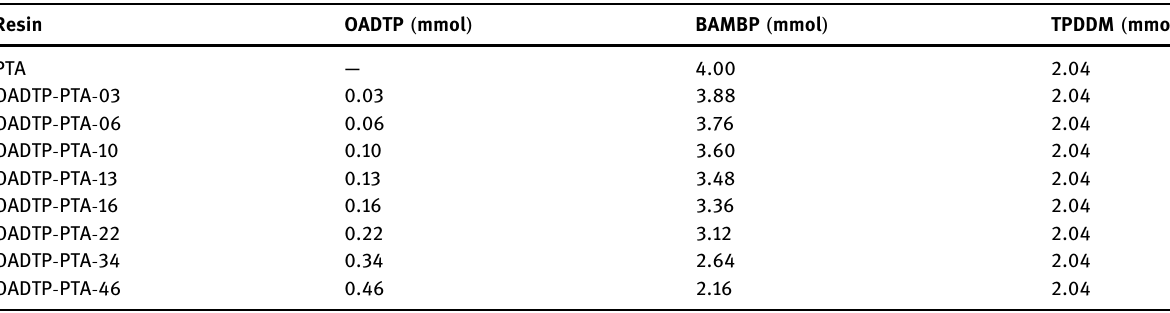
Table 1: The formulation of reactants for the synthesis of POSS - PTA